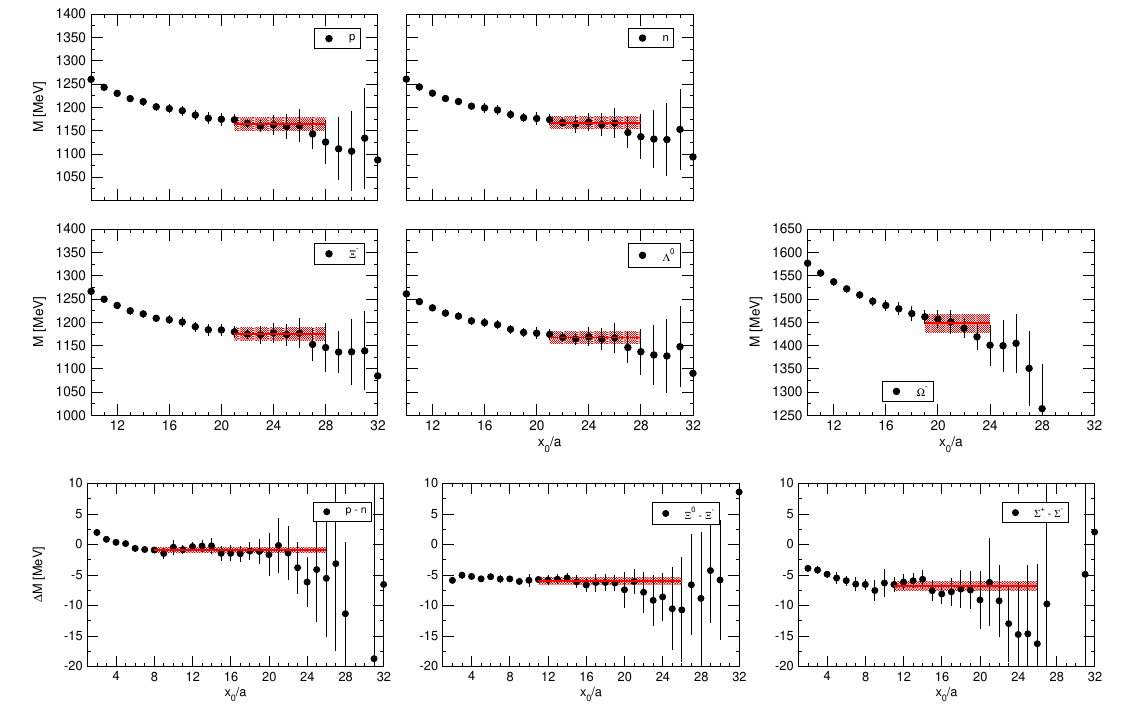
Figure 6 . Baryon effective masses for the ensemble A380a07b324+RW1 , with the selected plateaux and the fits to a constant. Values in MeV are obtained by using the reference value (8 t 0 ) 1 / 2 = 0 . 415 fm